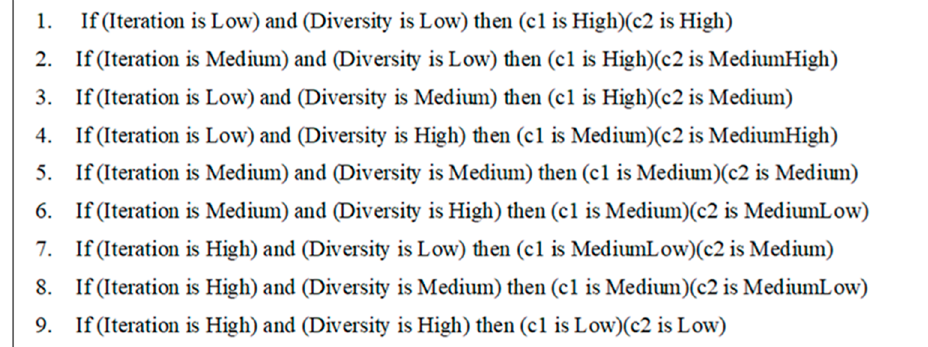
Figure 7. Fuzzy rules proposed for the fourth fuzzy system.